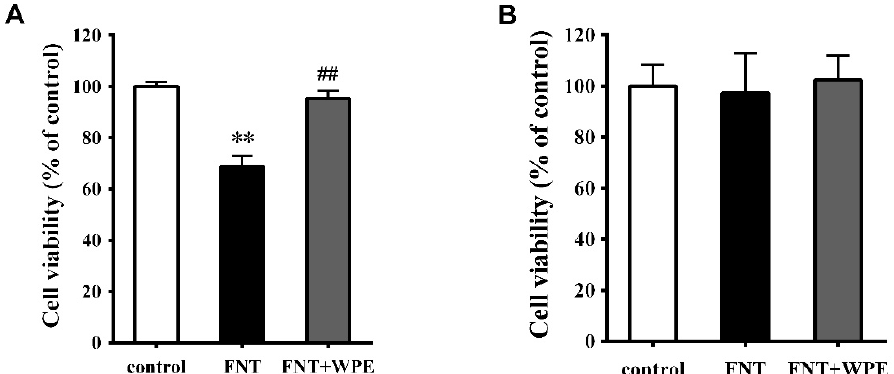
Figure 2. Effect of WPE on cytotoxicity of fenitrothion (FNT) in splenic lymphocyte subpopulations. Splenocytes were treated with FNT or WPE together with FNT for 48 h in the presence of Con A (5 µ g/mL) or LPS (10 µ g/mL). ( A ) Splenic cells stimulated with Con A (T lymphocytes) or ( B ) Splenic cells stimulated with LPS (B lymphocytes) viability was evaluated by an MTT assay. Controls were splenic cells cultured in medium contained Con A or LPS, untreated with FNT or WPE. Results shown are as mean ± SD of three separate experiments. ** p < 0.01, vs. control; ## p < 0.01 vs. FNT treatment.